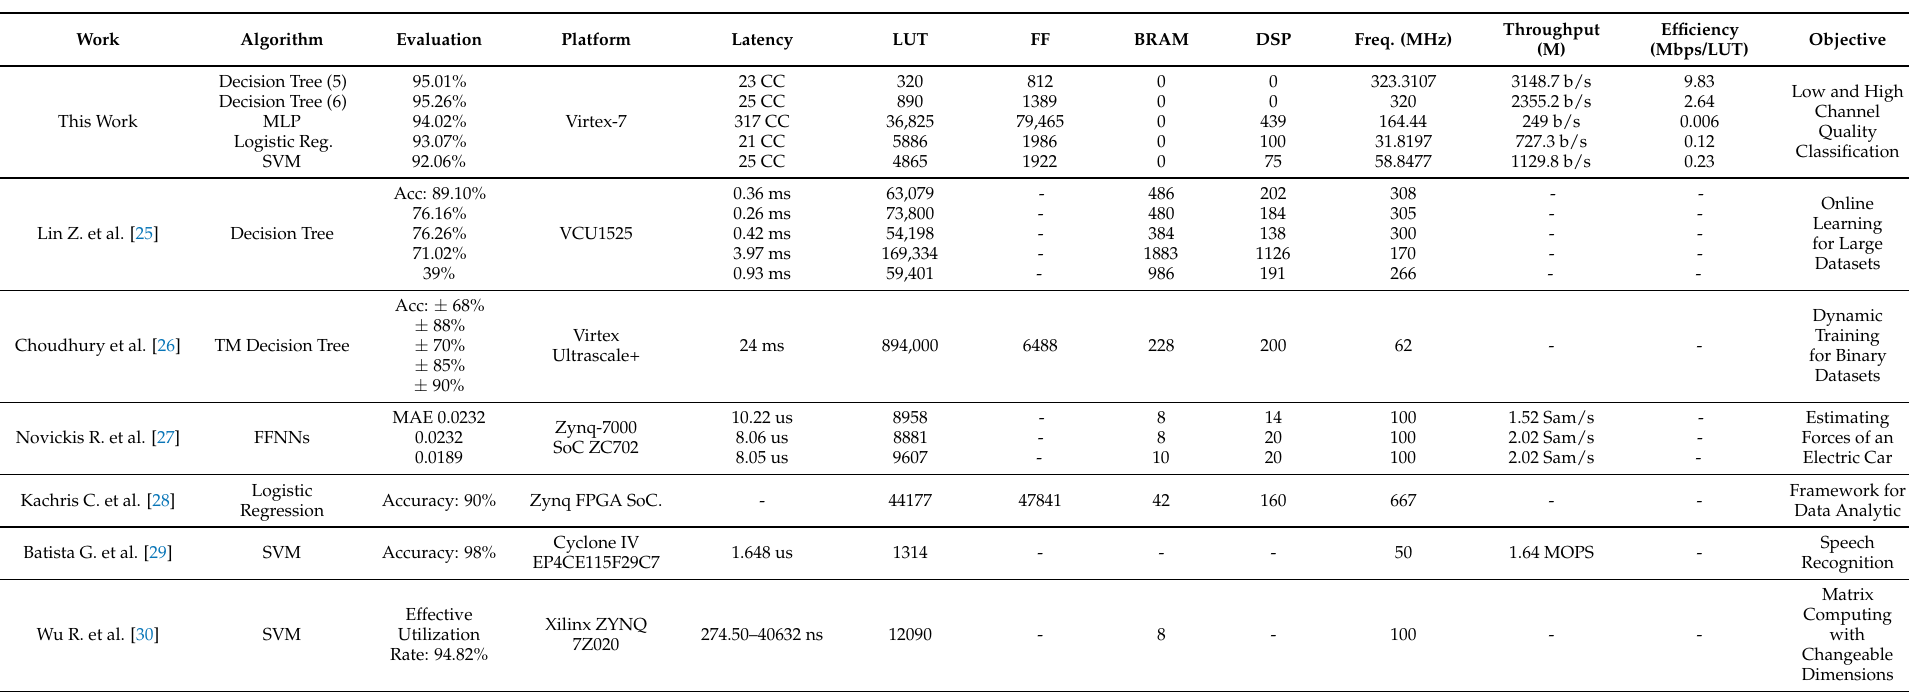
Table 4. Resource Comparison Among Different